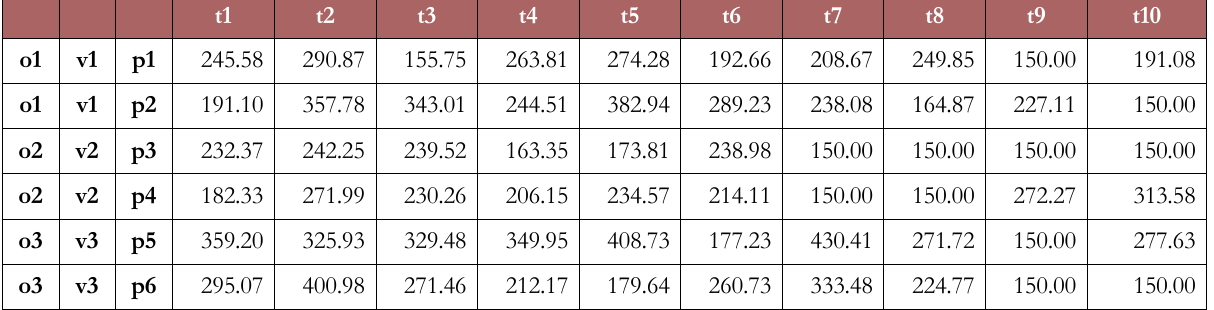
Table 7. Shipping quantity from the advanced warehouse to customers QO